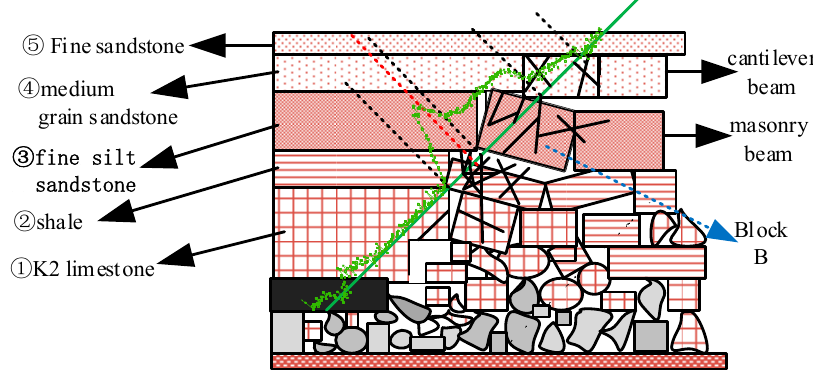
Figure 29. Schematic diagram of rock formation deformation on the fiber-optic section on 8 September.